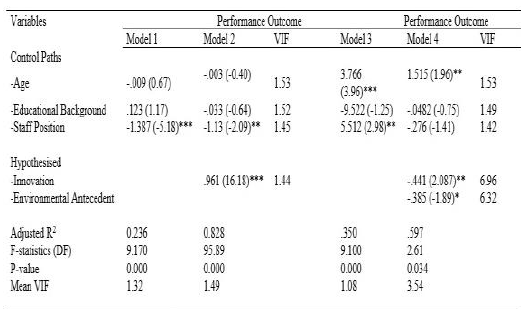
Table 6: OLS Regression Analysis